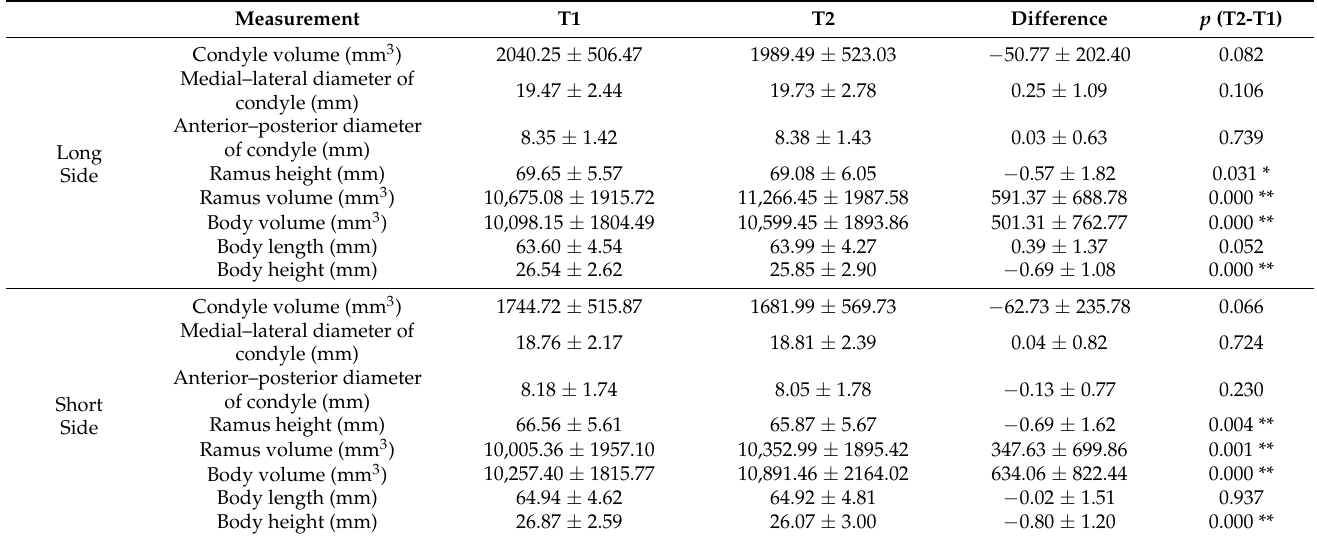
Table 5. Comparison of the mandibular morphology on the same side immediately after (T1) and at over 6 months after surgery (T2) in patients with asymmetric mandibular